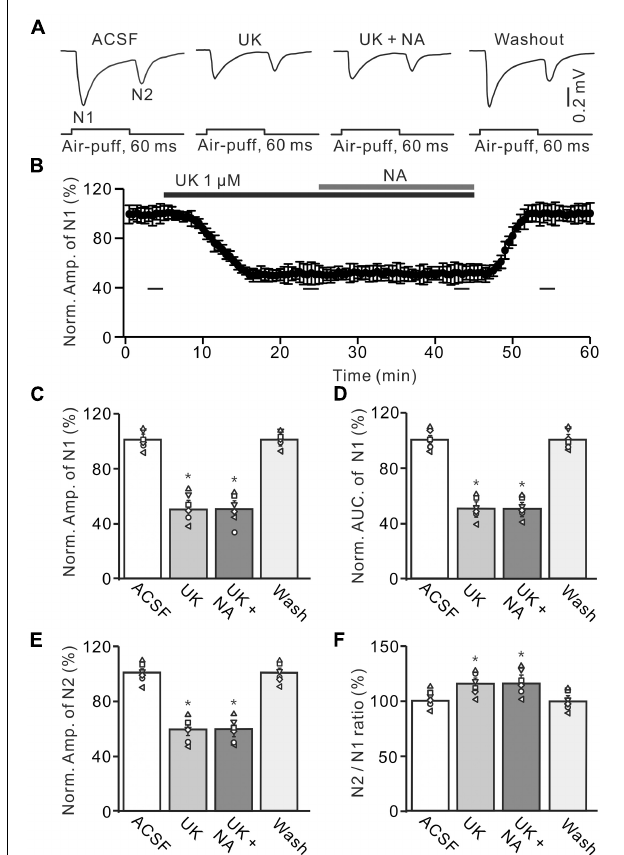
FIGURE 6 | Effect of α 2-AR agonist, UK14304 (UK) on the NA induces inhibition of the MF-GC synaptic transmission. (A) Representative field potential traces showing the facial stimulation (60 ms, 60 psi) evoked responses in a mouse cerebellar GL during treatment with ACSF, UK14304 (UK; 1 µ M), UK + NA (25 µ M), and recovery (washout). (B) Summary of data showing the time of course of normalized amplitude of N1 during treatment with ACSF, UK14304, UK + NA and recovery (washout). (C,D) Mean value ( ± SEM) with individual data showing the normalized amplitude (C) and AUC (D) of N1 during each treatment. (E,F) Mean value ( ± SEM) with individual data showing the normalized amplitude of N2 (E) and the N2/N1 ratio (F) during each treatment. * p < 0.05 versus control (ACSF). n = 6 in each